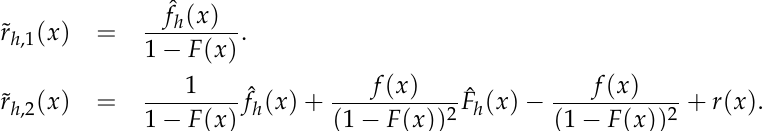
Figure 1. Boxplot of log (second box), h PCV (third box), h ∗